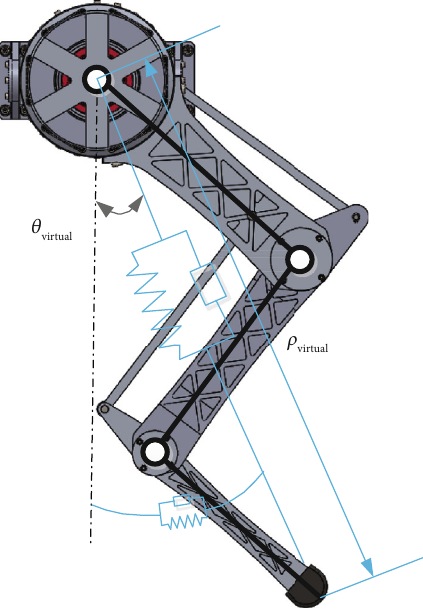
Figure 7: Virtual impedance model of the